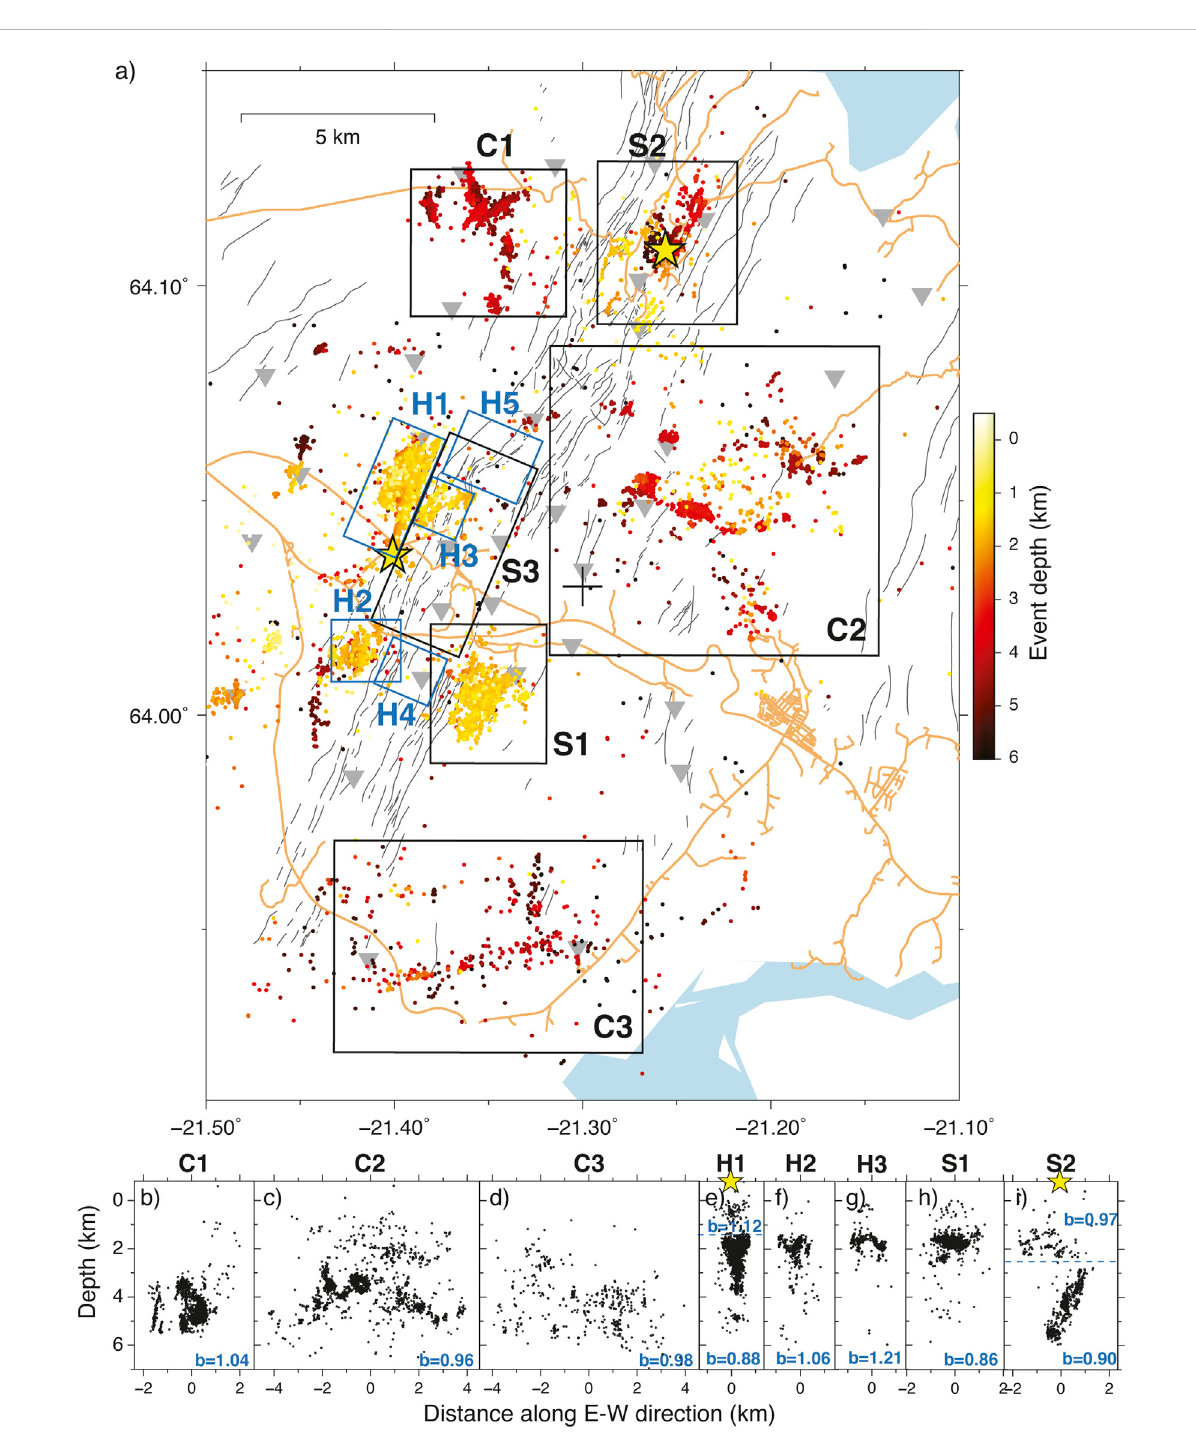
FIGURE 7 (A) Double-differencerelocatedHQearthquake catalog of theHengill region fromDecember 2018 toAugust2021. The event ’ scolorindicates thefocaldepth.TheseismicityoccursinclustersthatwelabelasH1-H5intheinjectionareas(Húsmúli,Gráuhnúkar,Sleggja,Lakahnúkar,Innstidalur) and S1-S3 in the production areas (Hverahlíð, Nesjavellir, Hellisheidi). Clusters C1-C3 (Mosfellsheiði, Hrómundartindur, Ölfus-Bakki) are outside the main production areas, where fewer boreholes are located. (B – I) Vertical distribution of seismicity along E-W direction and b-values for each